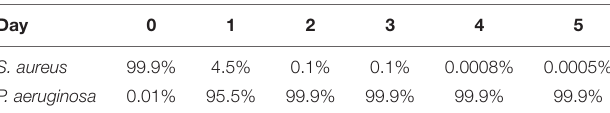
TABLE 4 | Ratio of S. aureus and P. aeruginosa when co-cultured in dual-species biofilms on 24-well plates at 37 ◦ C with